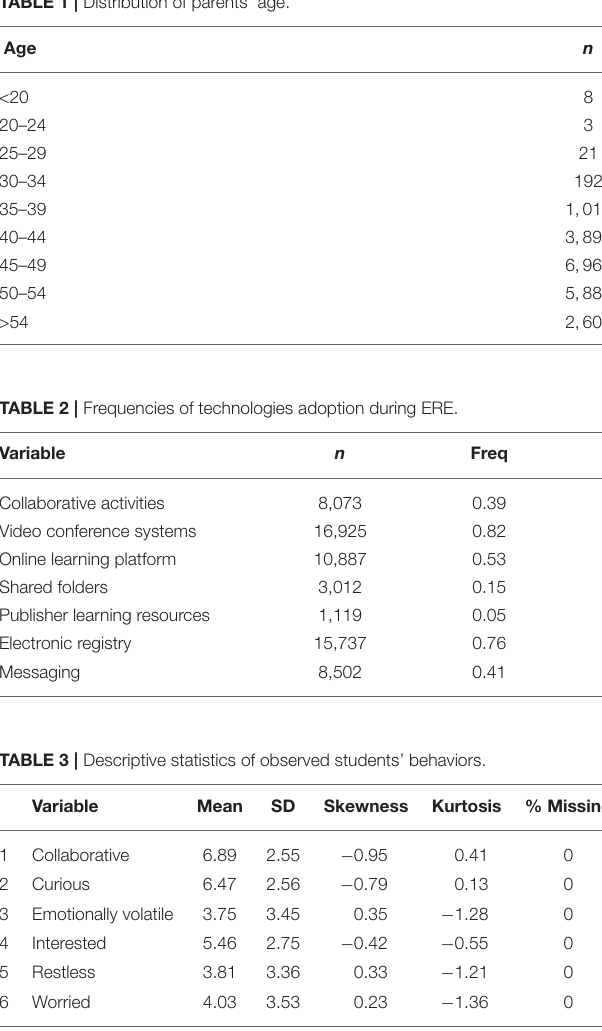
TABLE 4 | Correlations of observed students’